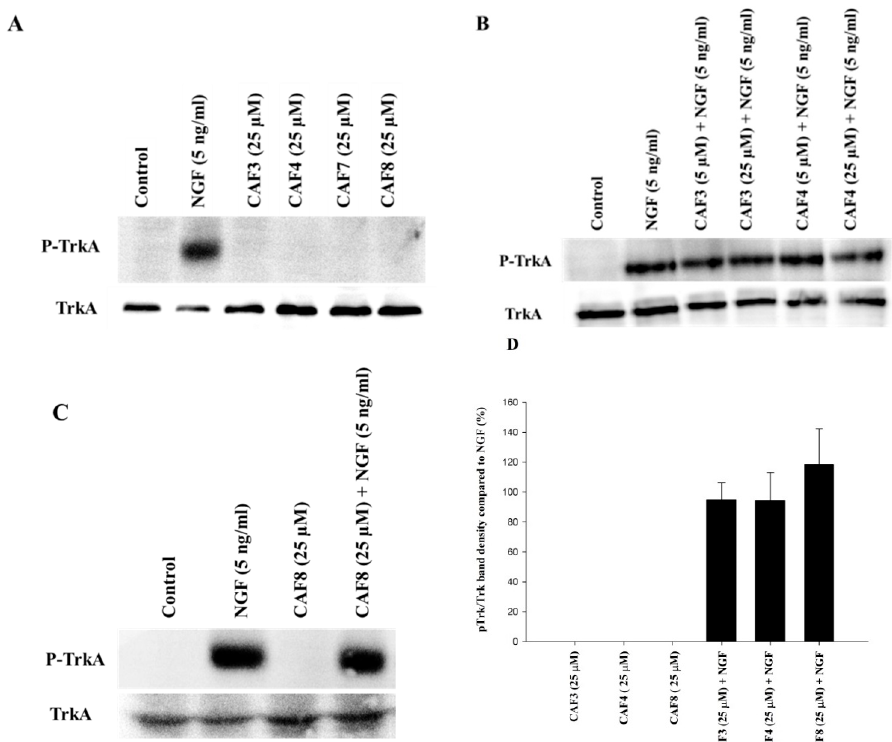
Figure 2. Assessment of tropomyosin ‐ receptor kinase A (TrkA) phosphorylation in PC12 cells exposed to synthesized caffeate esters. PC12 cells were seeded in collagen ‐ coated petri dishes and exposed to caffeate esters and/or NGF (5 ng/mL). After 30 min, the total cell protein was harvested in ice ‐ cold RIPA lysis buffer containing protease inhibitors. The proteins were separated on 7.5% SDS − PAGE, transferred onto a PVDF membrane and probed with specific antibodies. No band was detected in cells treated with caffeate esters alone ( A–C ). The band intensities of p ‐ TrkA and TrkA in PC12 cells treated with caffeate esters were quantified. The intensity of each p ‐ TrkA band was first divided by the band intensity of the respective TrkA. The p ‐ TrkA/TrkA ratio of each blot was then normalized to a p ‐ TrkA/TrkA ratio of NGF at 5 ng/mL. This figure shows the mean of three experiments ± SEM. No significant effect was observed in cells treated with a combination of caffeate esters and NGF compared to cells treated only with NGF ( D ).